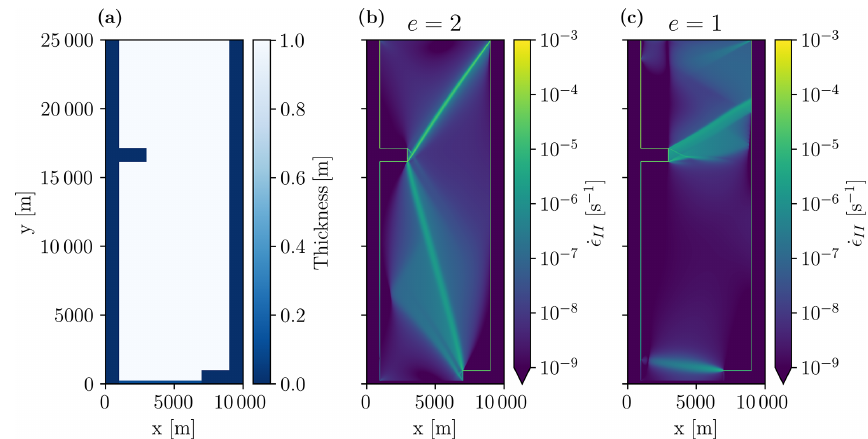
Figure 9. Sea ice thickness with two ice-free areas (a) and maximum shear strain rates for two different ellipse aspect ratios (b, c) after 5s of integration. The position of the ice weaknesses determines the location and angle of the fracture lines, and also the rheology parameter e has an entirely different effect. The main fractures lines are at angles of 25 and 34 ◦ for e = 2 . 0 and 57.6 ◦ for e = 1 . 0.